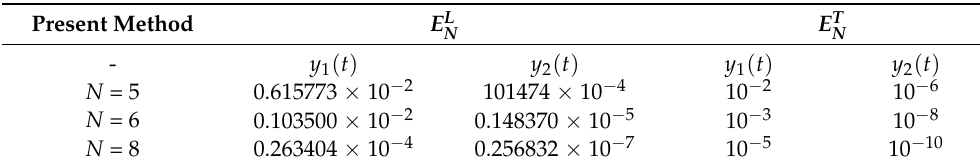
Table 3. Numerical result for Example 2.